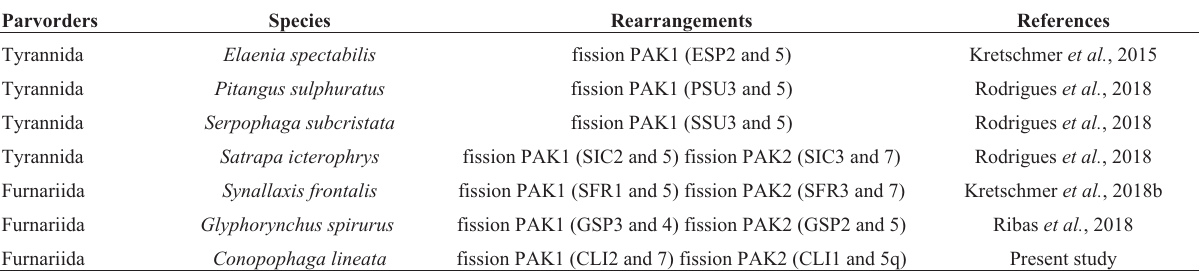
Table 1 - Rearrangements in putative avian ancestral karyotype homologous segments (PAK1-10) in Suboscines